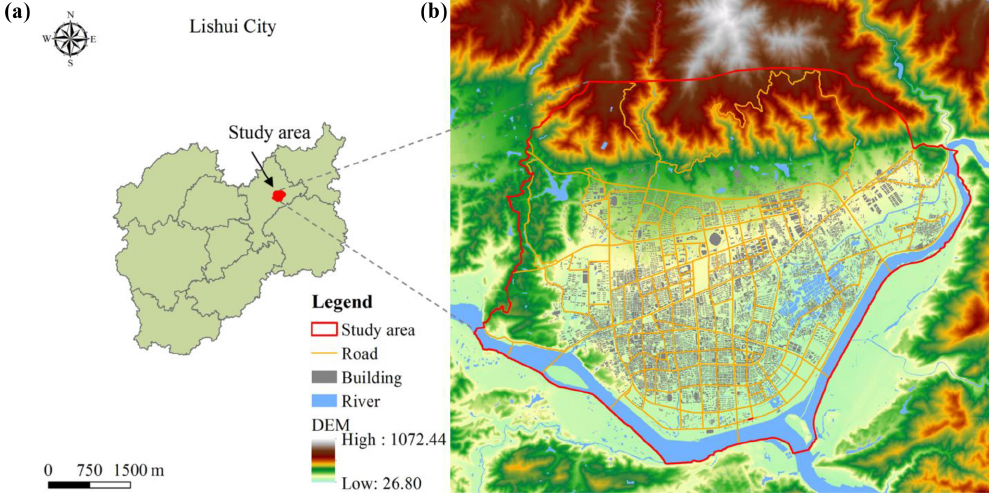
Figure 1. Location of the study area (a) and a digital elevation model indicating the specific details of the study area (b) .